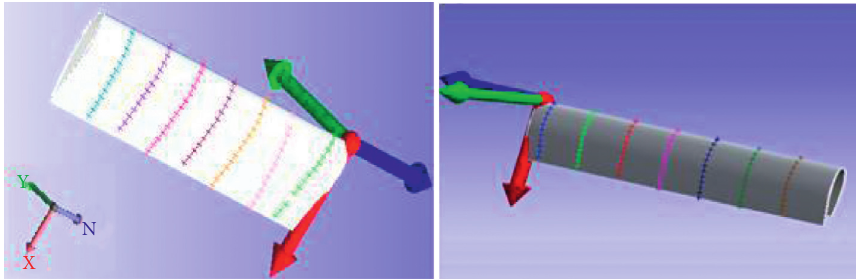
Figure 7: SpatialAnalyzer display of imported